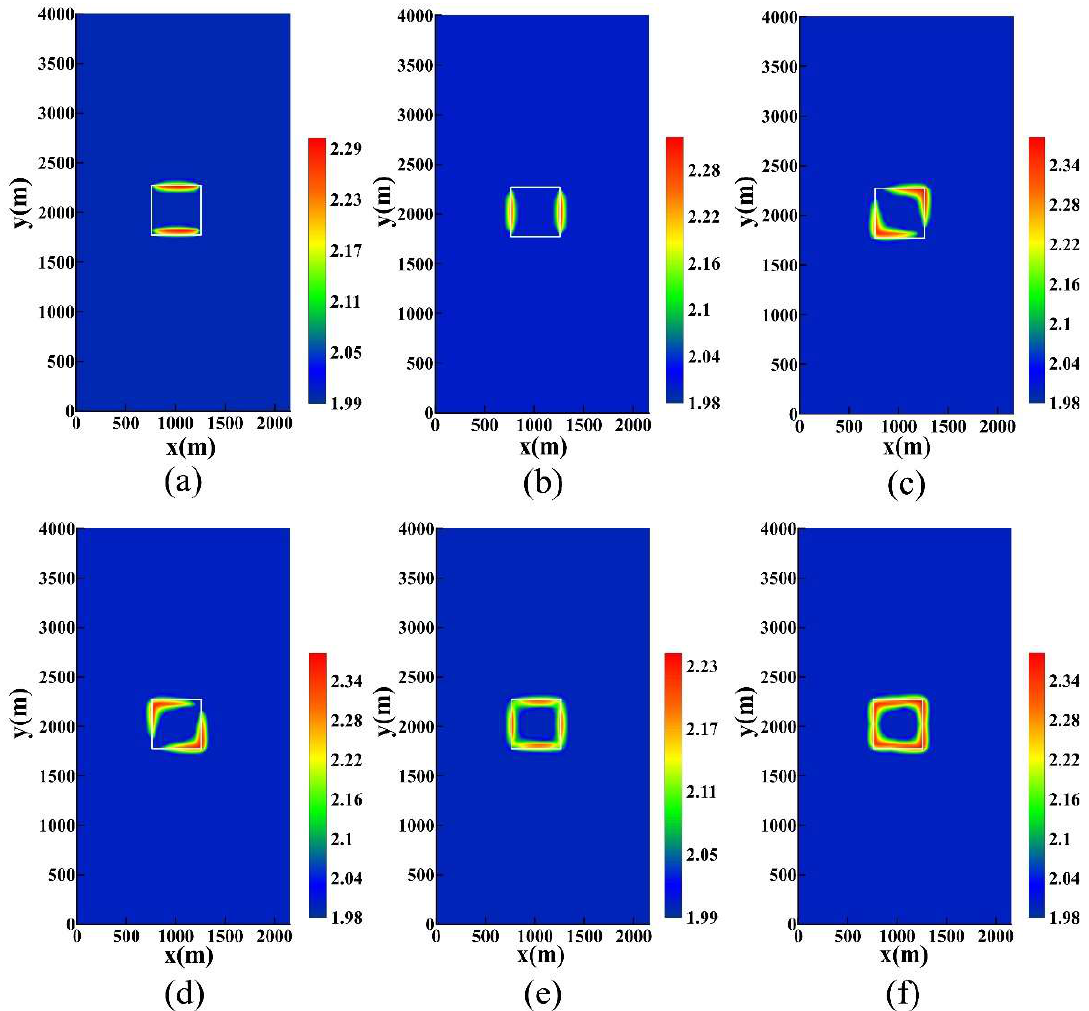
Figure 4. Fractal dimension results. ( a ) S-N direction; ( b ) W-E direction; ( c ) WN-SE direction; ( d ) NE-SW direction; ( e ) the maximum fractal dimension; ( f ) the average fractal dimension.